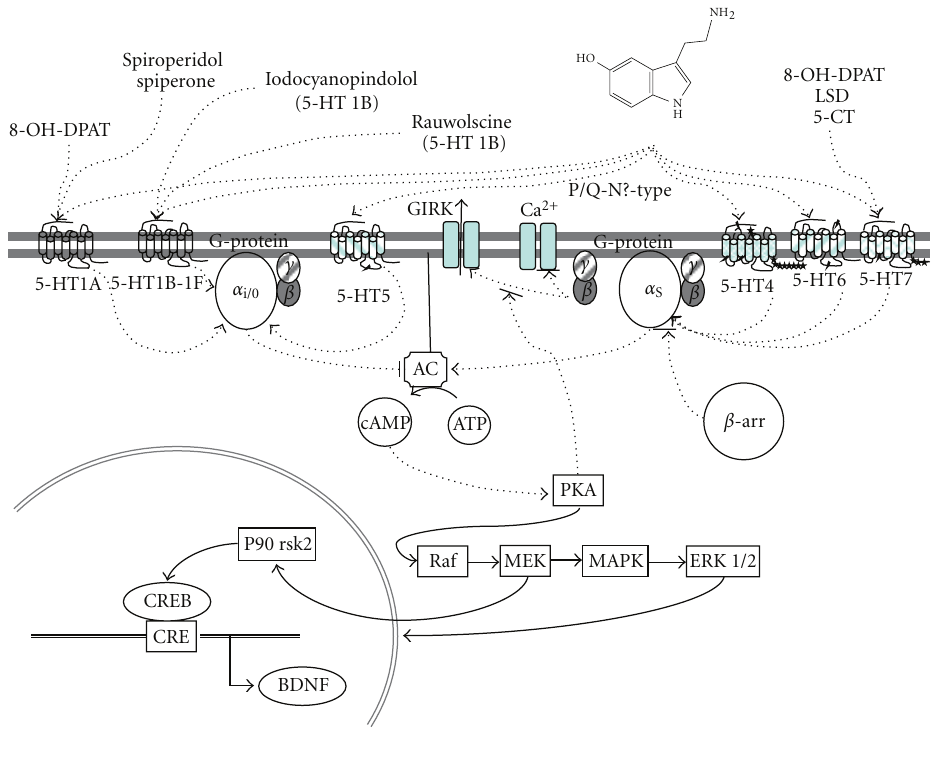
Figure 4: cAMP signaling pathways. Serotonin receptors 5-HT 1 and 5-HT 5 interact with α i / 0 G-protein inhibiting the formation of cyclic adenylate monophosphate (cAMP) by adenylate cyclase (AC), while 5-HT 4 , 5-HT 6 , and 5-HT 7 activate AC by means of α S G-protein. βγ subunits of G-protein may interact in other signaling pathways, for example, modulating GIRK or calcium voltage gated channels. Representation of β -arrestin ( β -arr) is made to indicate other signaling pathways. Traditional ligands to study di ff erent subtype receptors are written in the extracellular zone; note that 5-HT 7 may bind the traditional ligand for 5-HT 1A as well as LSD (5-HT 2